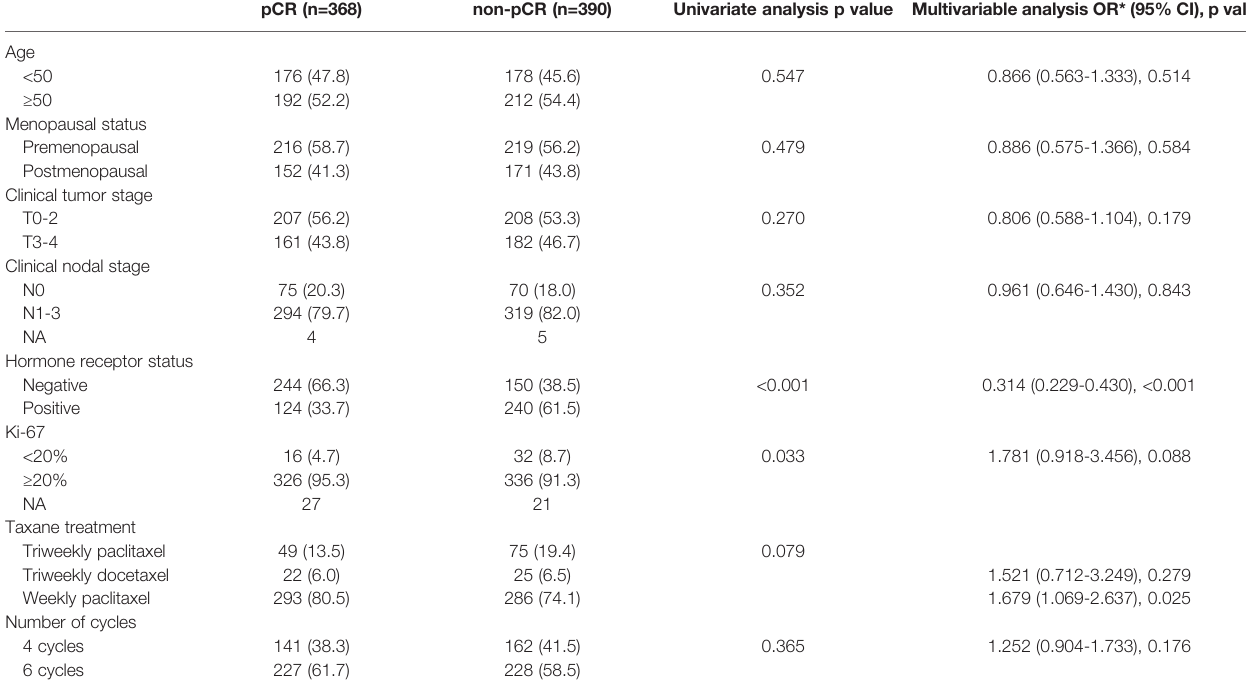
TABLE 2 | Subgroup analysis of the correlation between the pCR rate and number of cycles. pCR (n=368) non-pCR (n=390) Univariate analysis p value Multivariable analysis OR* (95% CI), p